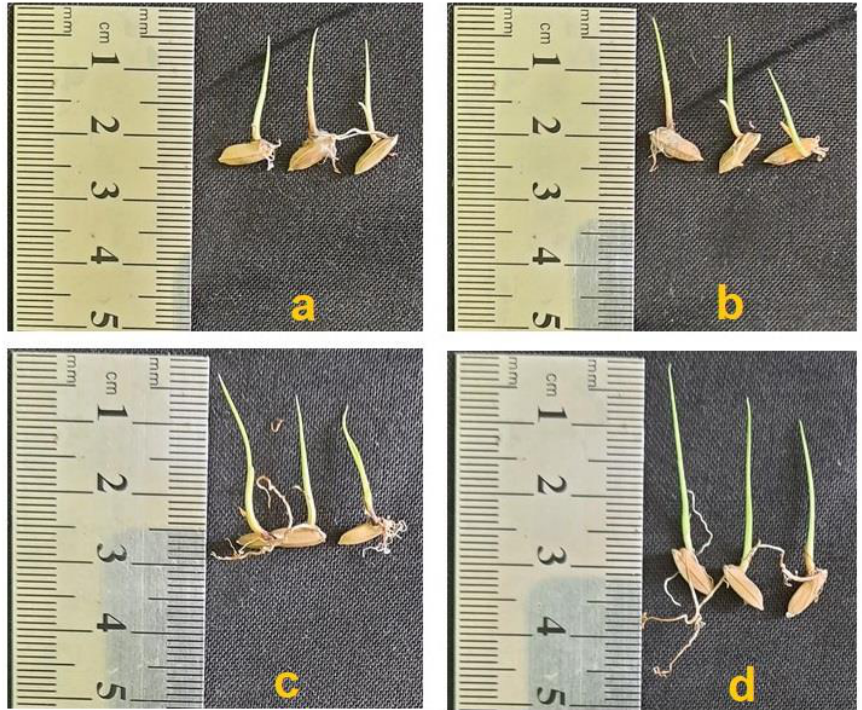
Figure 6. Assessment of BINAdhan-10 rice seedlings treated with three bacterial isolates at 1% salinity. ( a ) Control; ( b ) BTCoSo2; ( c ) BTCoR2, and ( d ) B. sediminis strain IBGE3C.